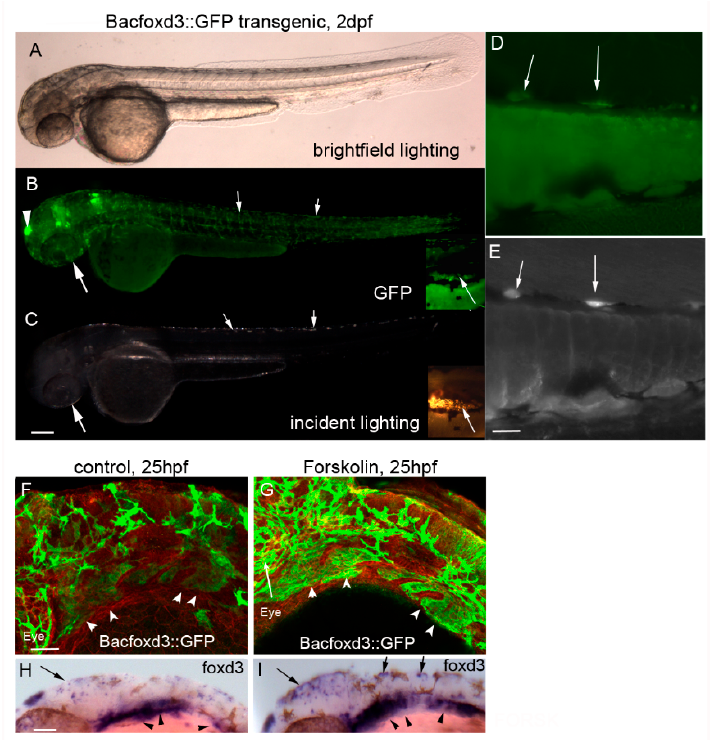
Figure 6. Forskolin increases expression of the mitfa transcriptional repressor foxd3 . ( A – C ) 10× magnification of Bacfoxd3::GFP transgenic larvae at 2 dpf. Transgenic zebrafish express GFP in foxd3-dependent cells including the pineal gland (arrowhead) and presumptive iridophores (arrows). Scale bar in panel C = 200 um and applies to panels A–C. ( D – E ) 20× magnification of BACfoxd3::GFP zebrafish. Arrows indicate cells co-expressing GFP and iridescence typically observed in iridophores. The scale bar in panel E = 100 um and applies to panels D and E. ( F , G ) 20× magnification of 25 hpf 0.1% DMSO or 5 µM forskolin-treated BACfoxd3::GFP transgenic fish processed for immunocytochemistry using anti-GFP and anti-beta catenin antibodies (red). Forskolin treatment leads to an increase in GFP (arrowheads indicate pharyngeal arches), indicating expanded domains of foxd3 expression. Scale bar in panel F = 100 um and applies to panels F and G. ( H , I ) 0.1% DMSO and 5 µM forskolin-treated wildtype embryos processed for in situ hybridization using the foxd3 probe. Forskolin expands the areas of foxd3 expression, notably in the dorsal head and trunk regions (arrows) which are locations of presumptive iridophores, and in pharyngeal arch neural crest streams (arrowheads). Scale bar in panel H = 100 um and applies to panels H and I.